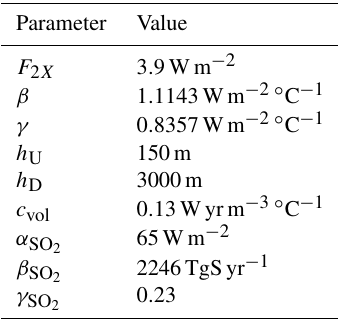
Table 3. Parameter values for the temperature module.